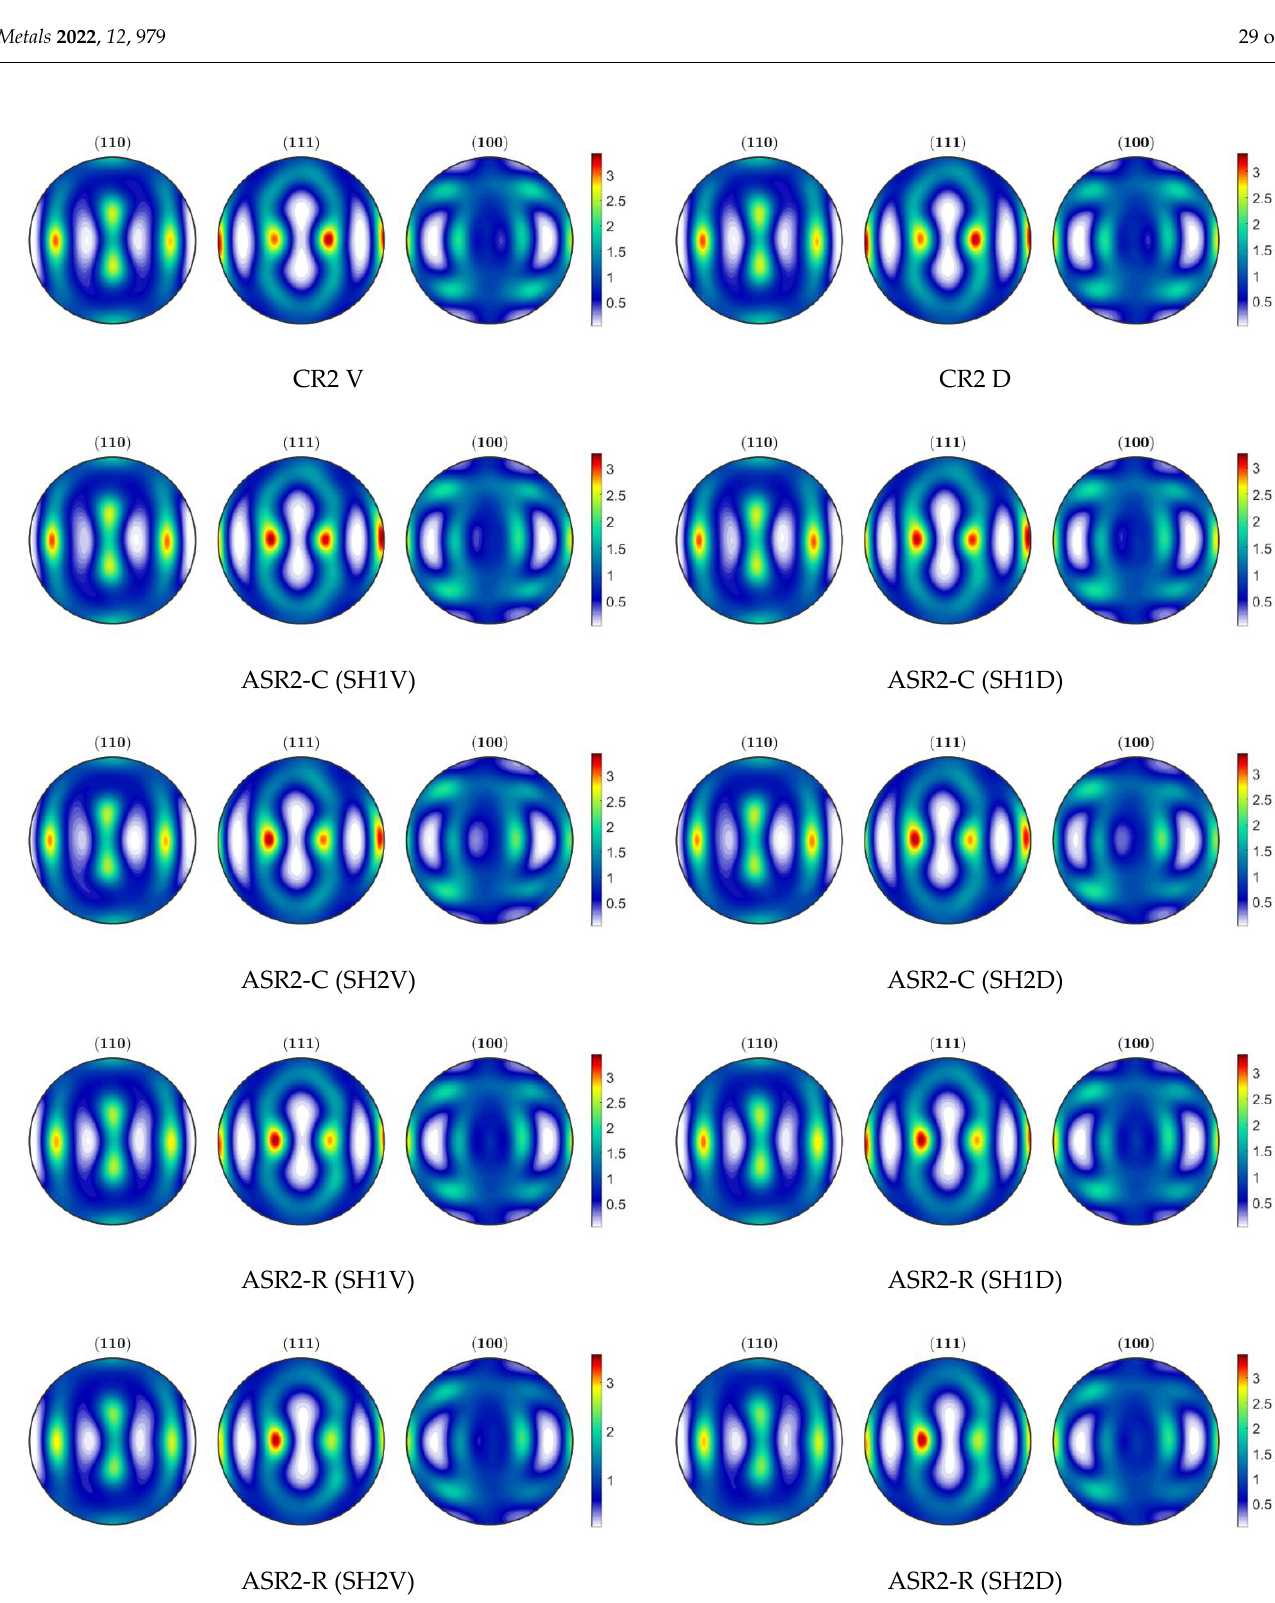
Figure A12. Pole figures for the second pass with a 30% thickness reduction per pass.